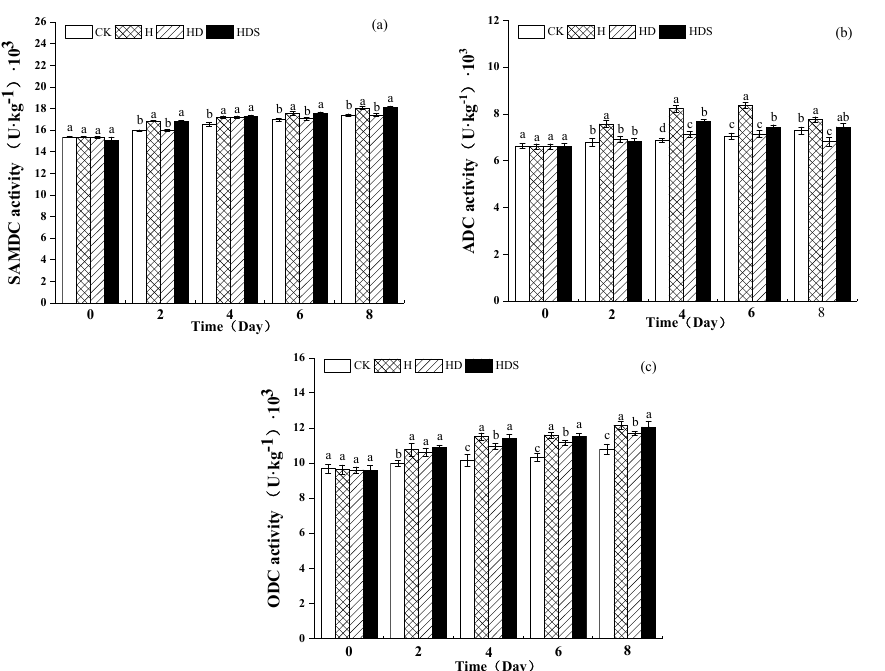
Figure 6. Effects of exogenous spermidine and D - arg on the activities of SAMDC ( a ), ADC ( b ), and ODC ( c ) in lettuce under high-temperature stress. Vertical bars represent standard deviations of the mean ( n = 3). Values above each vertical bar followed by different letters show significant differences ( p < 0.05). CK, 22 ° C /17 ° C , deionized water; H, 35 ° C /30 ° C , deionized water; HD, 35 ° C /30 ° C , 1 mM D - arg; HDS, 1 mM D - arg+ 1 mM Spd.